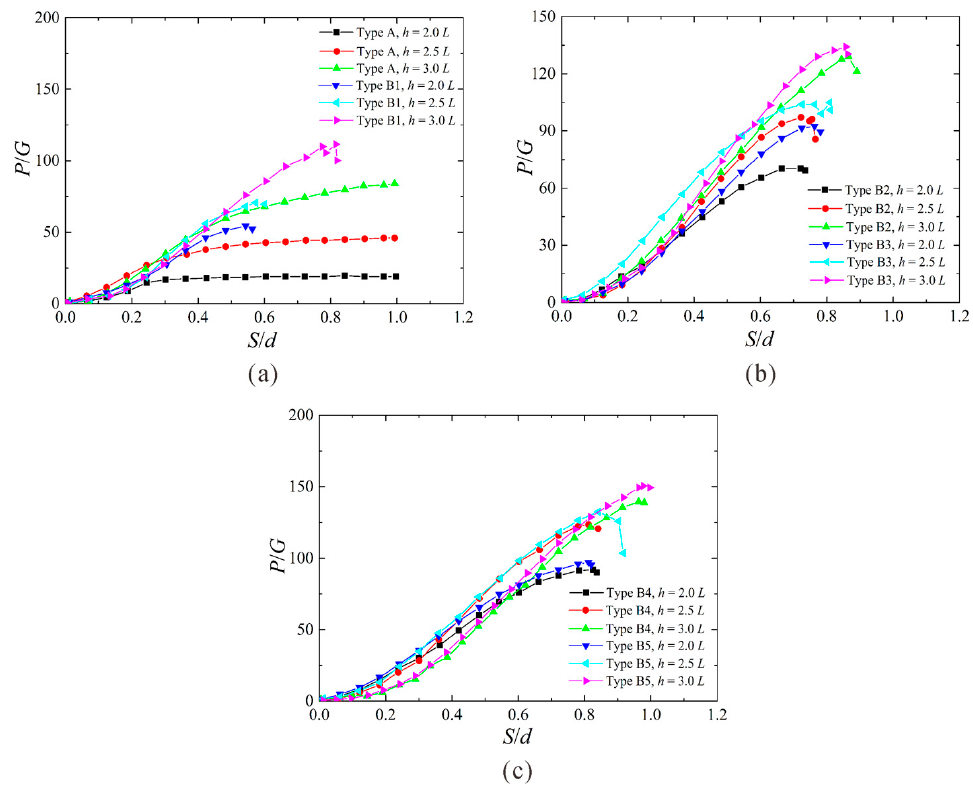
Figure 6. Effects of h on the load–displacement curves of the TAs under vertical pullout loading ( a ) Types A and B1; ( b ) Types B2 and B3; ( c ) Types B4 and B5.